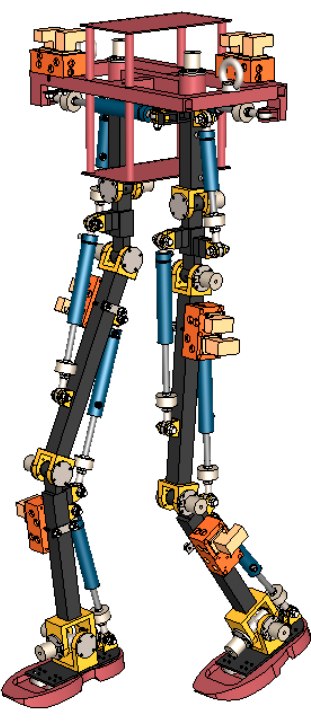
Figure 1. 12-DOF hydraulic-drive biped robot.